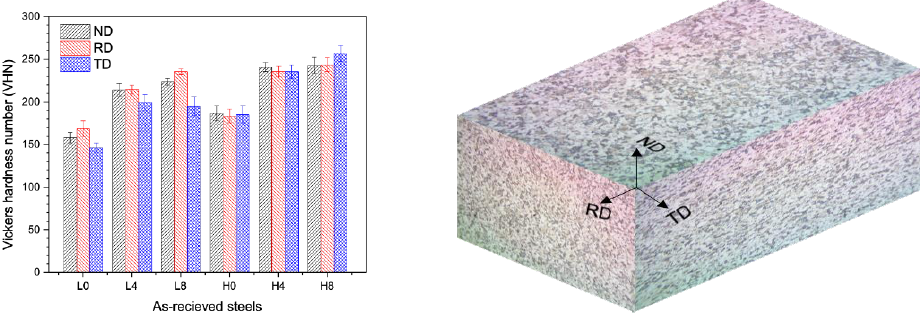
Figure 9. Vicker’s hardness number (VHN) values of air-cooled samples in three orthonormal directions.